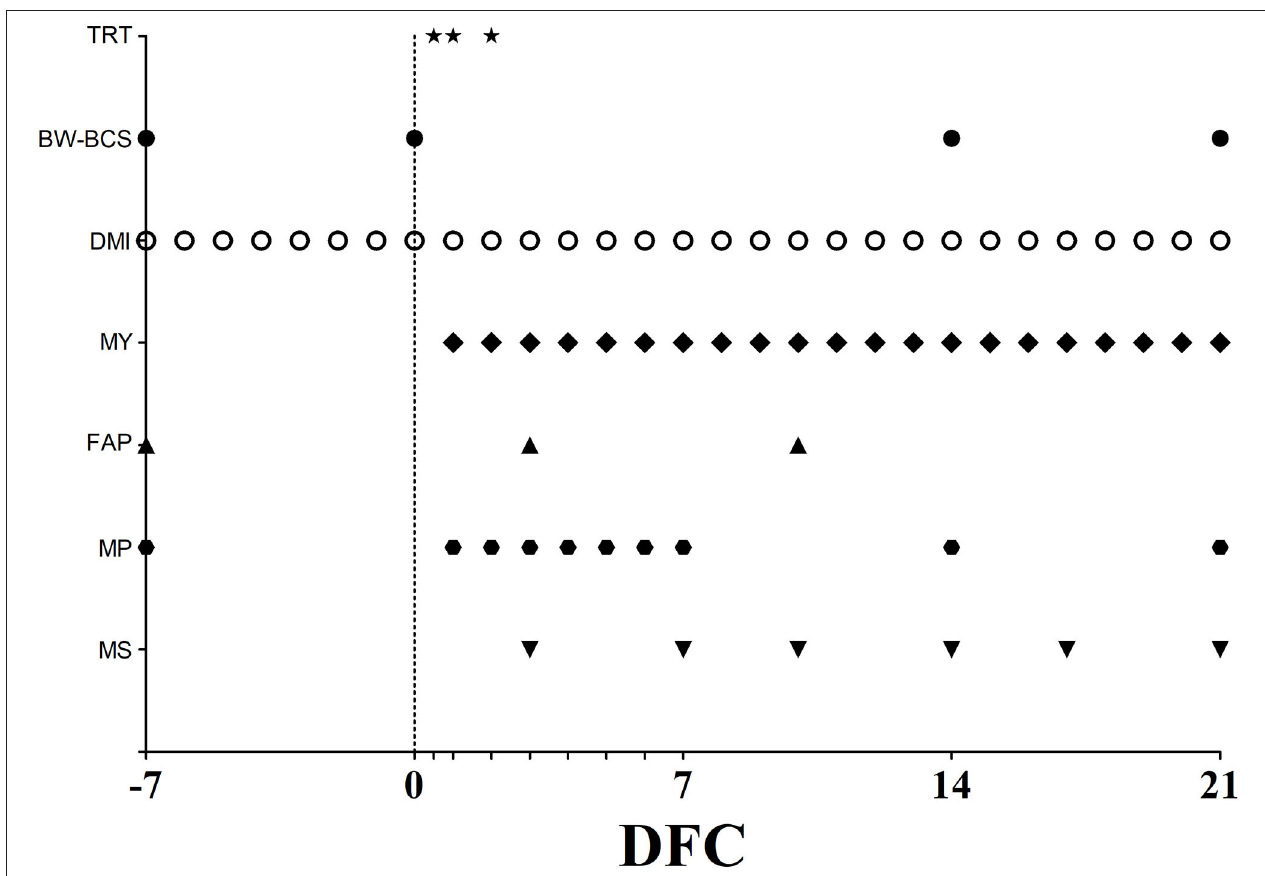
FIGURE 1 | Scheduled time points, expressed as day from calving (DFC), for jugular infusion of physiological solution or emulsified fish oil (TRT), body weight and body condition score determination (BW–BCS), dry matter intake measurement (DMI), milk yield recording (MY), blood samples collection for plasma fatty acids profile (FAP) and plasma metabolic profile assessment (MP), and milk sample collection (MS). Empty ticks indicate 0.5, 1, 2, 3, 4, 5, and 6 DFC,